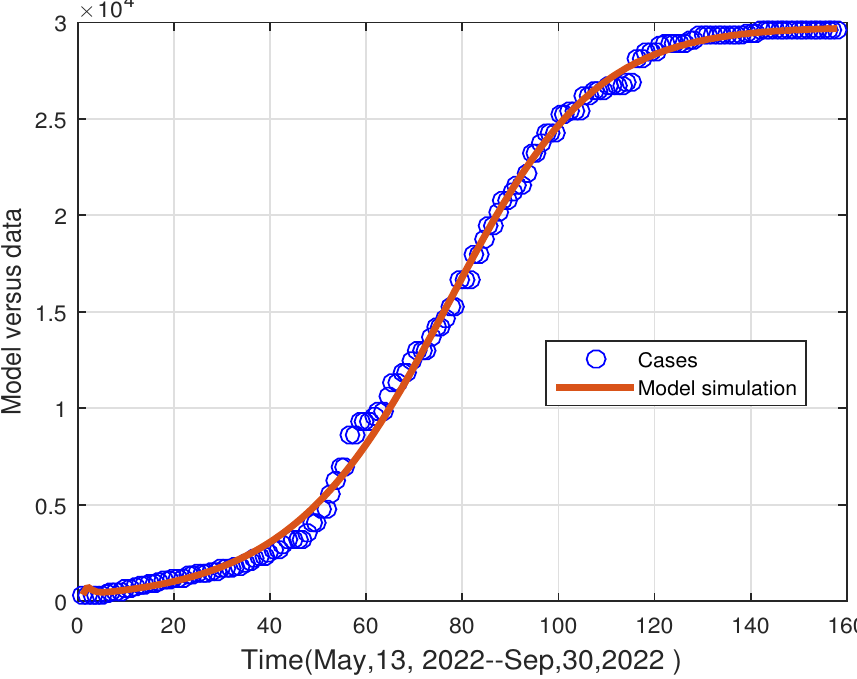
Figure 2. Data fitting to the model using the parameters given in Table